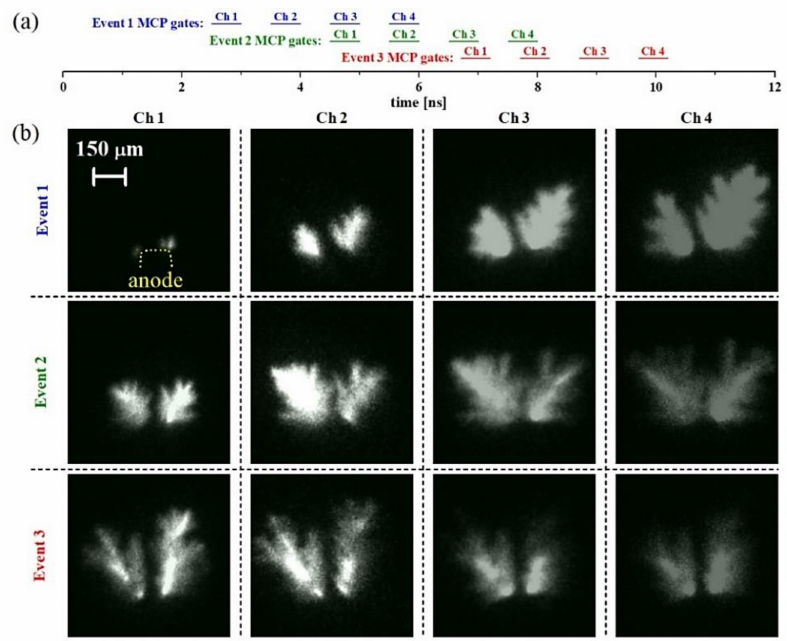
Figure 5. Case study A; image sequences obtained with broadband discharge emission. Horizontal bars in ( a ) labelled as Ch1–Ch4 illustrate the timing of the Ch1–Ch4 MCP gates with respect to the onset (time t = 0 ns) of the HV pulse. Images in panel ( b ) show the evolution of selected events during the primary HV pulse acquired by using equal Ch1–Ch4 MCP gates of 500